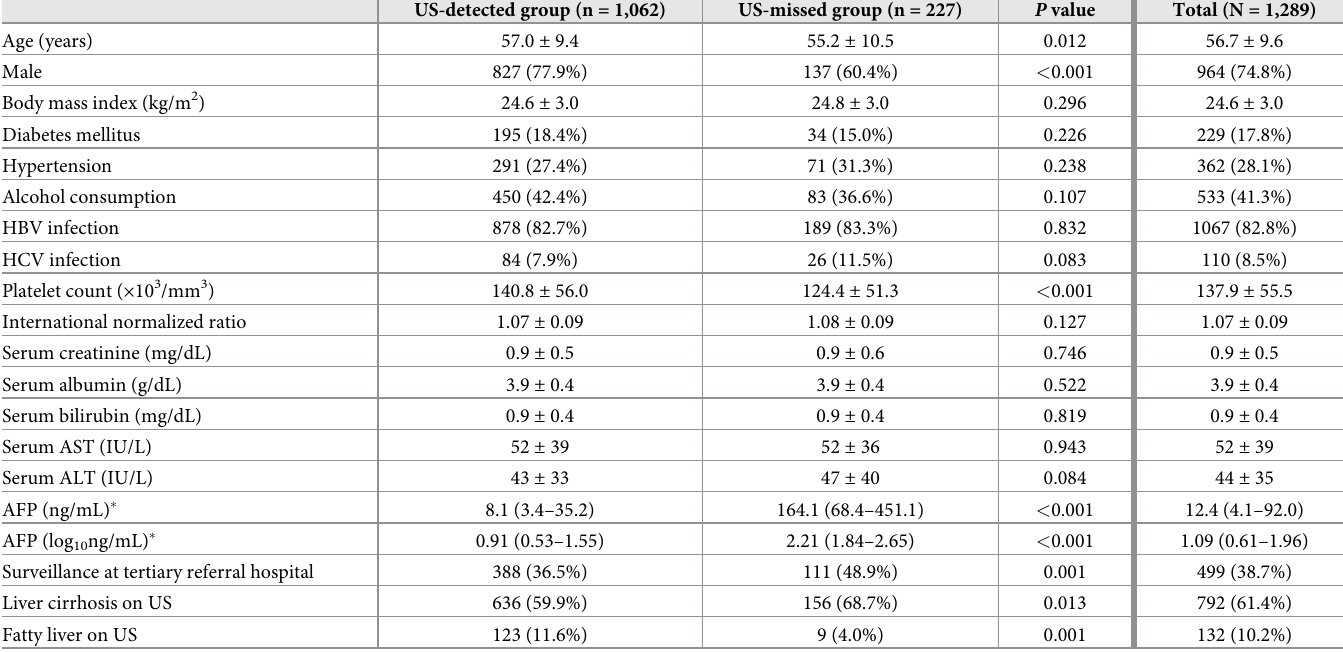
Table 1. Characteristics of 1,289 enrolled patients with Barcelona Clinic Liver Cancer stage 0-A single-nodular hepatocellular carcinoma detected during US surveillance.